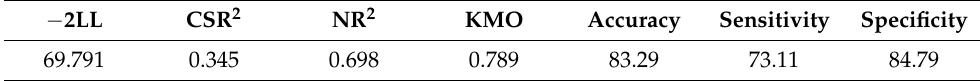
Table 9. Statistical indexes and AUC value of the hybrid